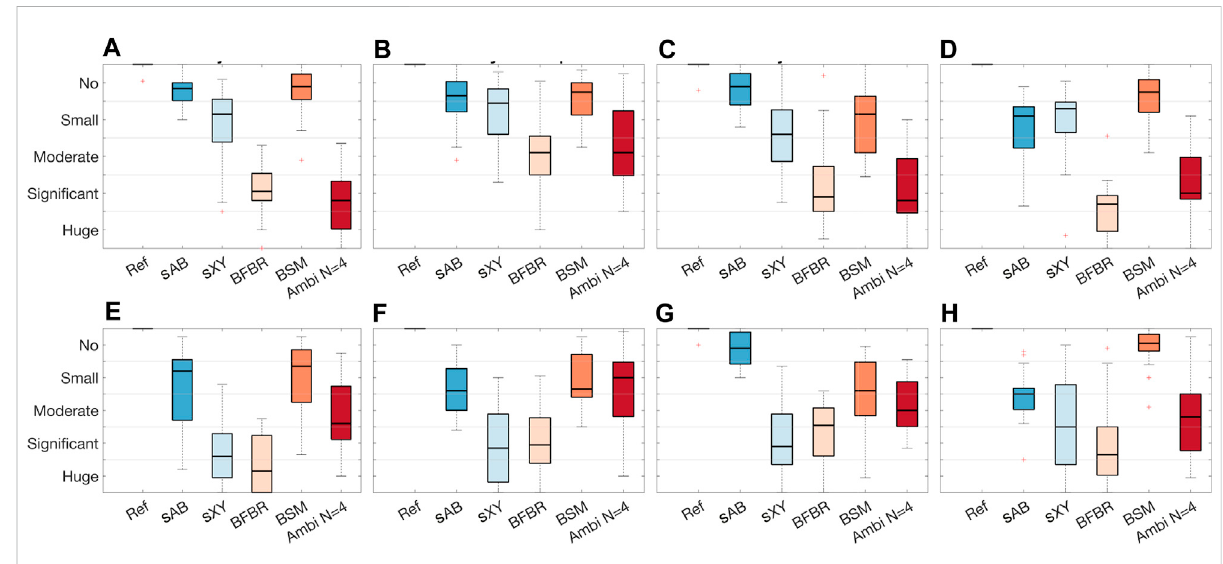
FIGURE 12 EXPERIMENT1:Boxplotsoftheinter-individualvariationintheMUSHRApointsforeachMUSHRApageseparately. (A) Timbre:dryEMA6drums, (B) Timbre: dry EMA6 speech, (C) Timbre: dry EMA8 drums, (D) Timbre: reverberation EMA6 drums, (E) Spaciousness: dry EMA6 drums, (F) Spaciousness: dry EMA6 speech, (G) Spaciousness: dry EMA8 drums, (H) Spaciousness: reverberation EMA6